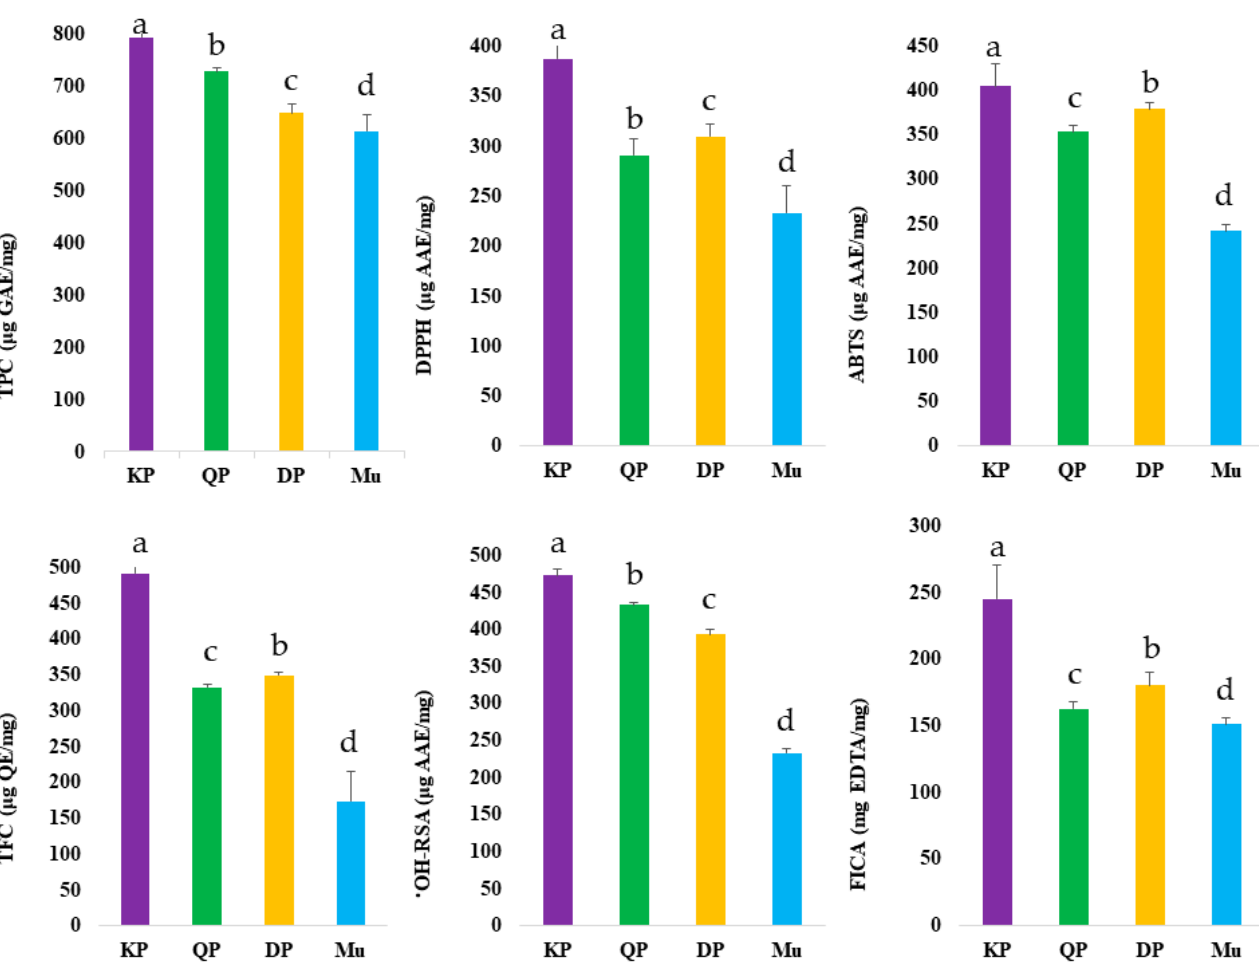
Figure 1. Quantification of phenolic contents and antioxidant activities of native Australian Muntries (Mu), Kakadu plum (KP), Davidson plum (DP), and Quandong peach (QP). Values with the letters (a–d) are significantly different from each other ( p < 0.05).